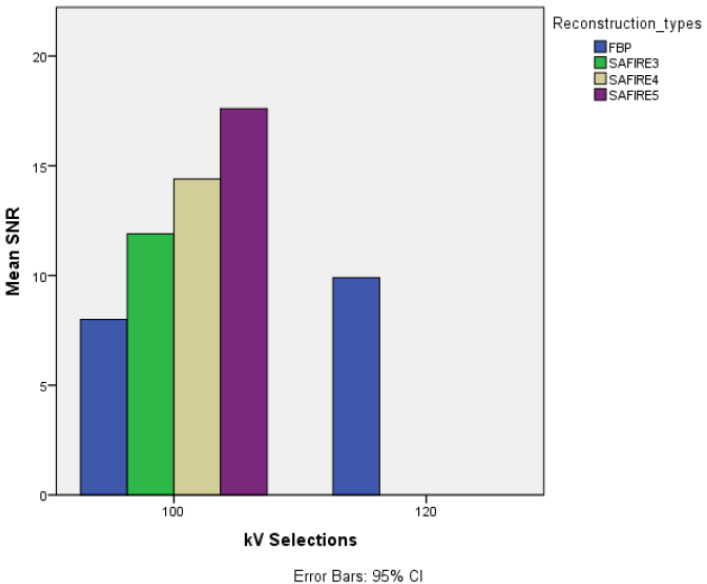
Figure 6. Mean signal to noise ratio (SNR) values for obese phantoms (at 200 mA) across the applied tube voltages selections and different reconstruction